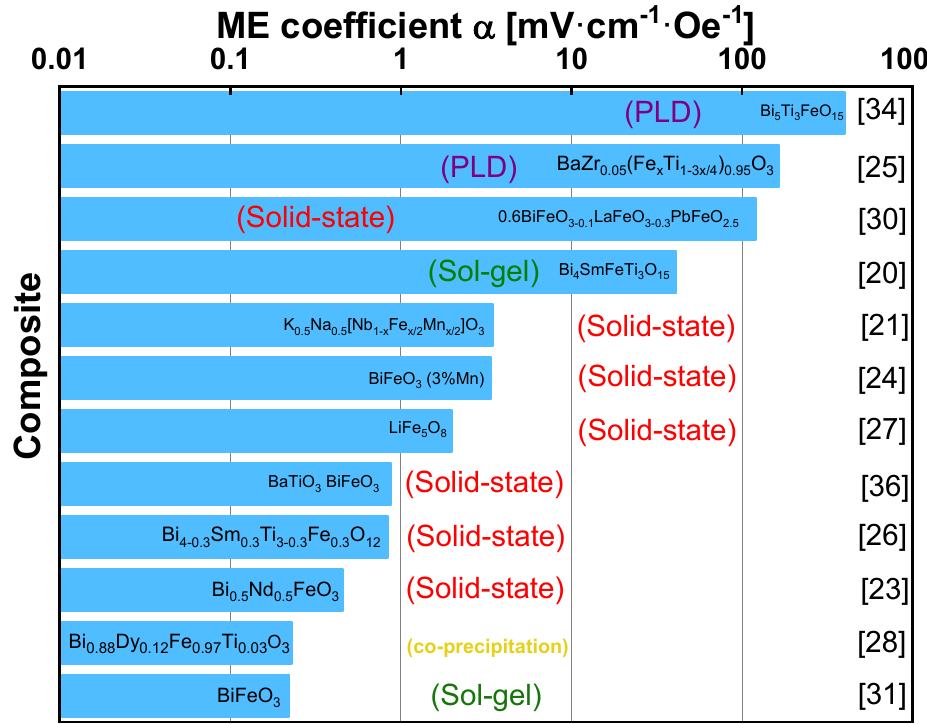
Figure 7. Some representative single-phase materials and their corresponding ME voltage coefficient and fabrication process.